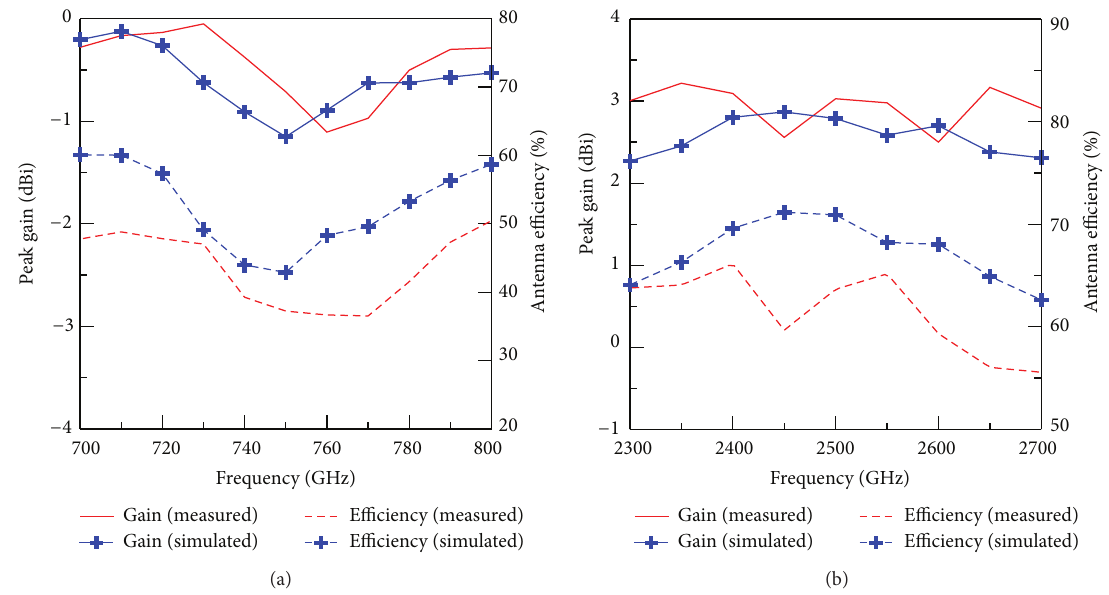
⋅ (1 − |𝑆 | 2 ) of the proposed antenna versus frequency at 11 rad